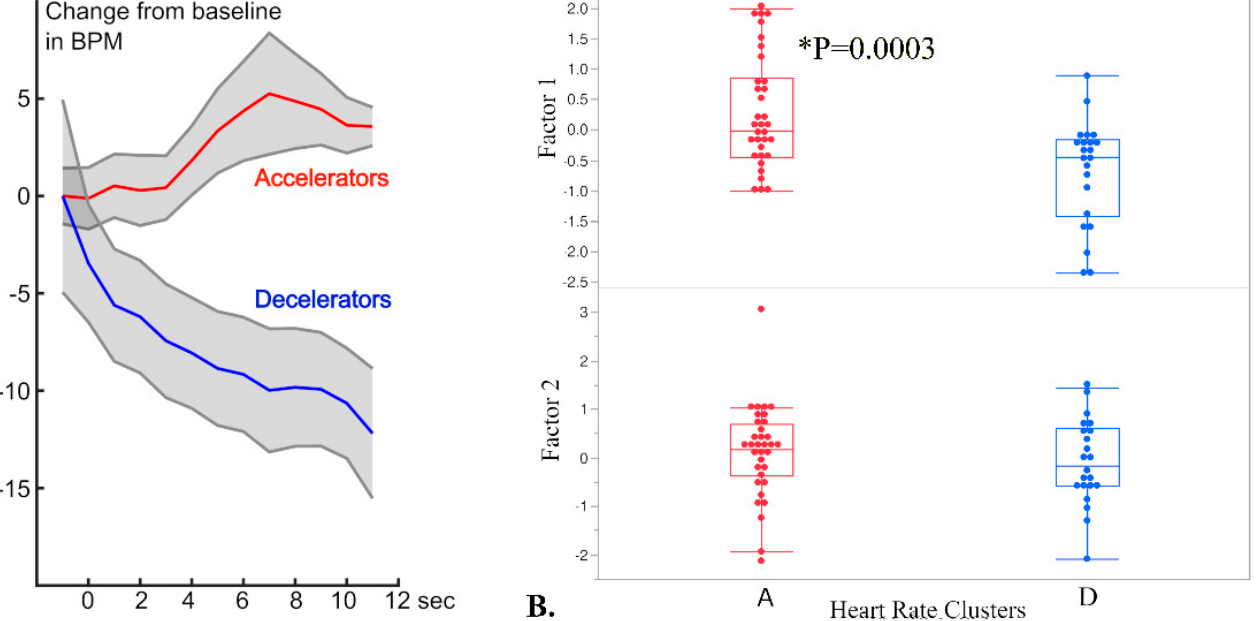
Figure 3. ( A ) Mean heart rate change time course relative to baseline, averaged across the members of the two clusters (red: accelerators; blue: decelerators; the grey shaded area defines the standard deviation). The time course is shown as relative change in BPM, for a time between − 1 to +11 s, relative to the startle event. ( B ) Effect of HR clusters and Factor scores. Accelerator horse cardiac response types had significantly higher Factor 1 scores summarizing the latency, flight distance, and standing facing away from the umbrella behaviors.